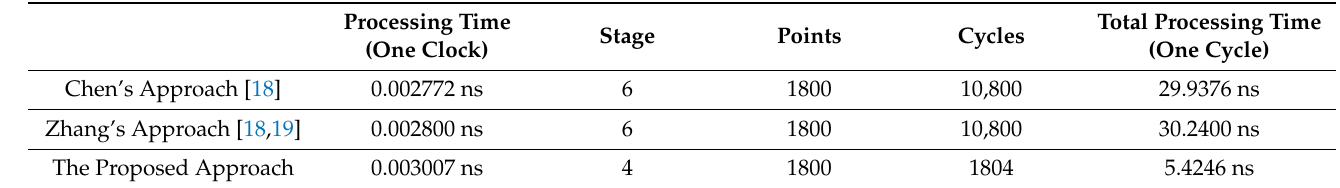
Table 5. Processing Time of Software-based Approaches and FPGA-based Proposed Approach.